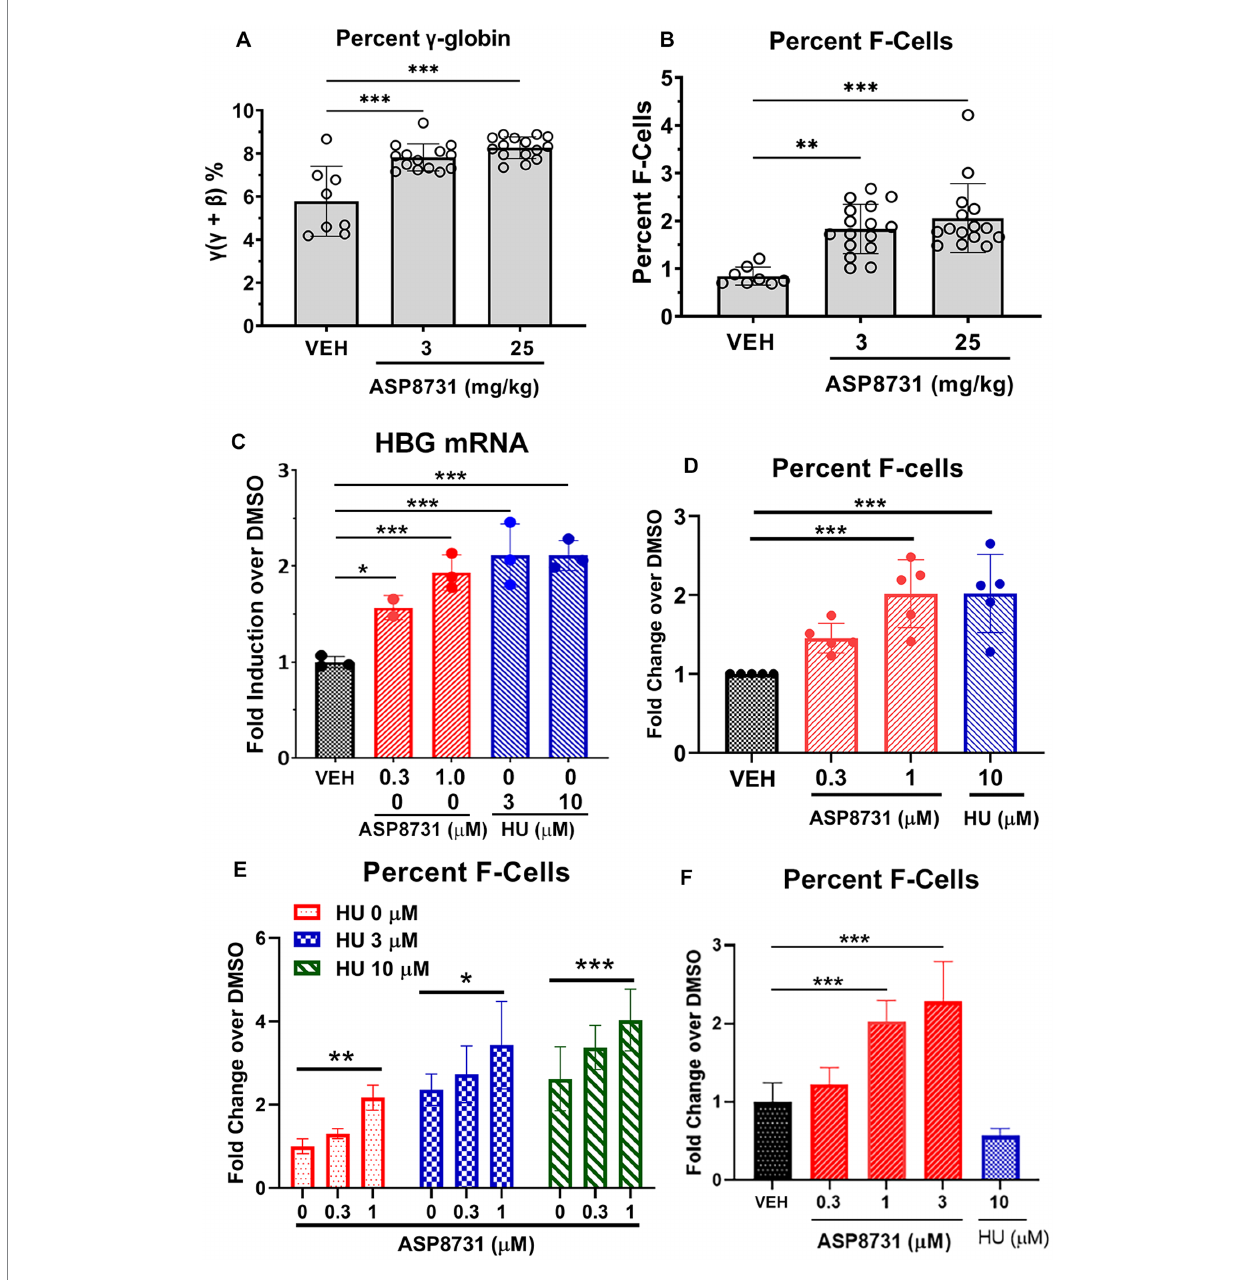
FIGURE 4 BACH1 inhibitor ASP8731 induces gamma globin and F-cells in HbSS mice and human erythroid differentiated CD34 cells. Townes HbSS mice ( n = 8–16 mice/treatment, equal males and females) were gavaged once daily for 14 consecutive days with vehicle (VEH, n = 8 mice) or ASP8731 at 3 mg/kg ( n = 16 mice) or 25 mg/kg ( n = 16 mice). Whole blood was collected on the last day of treatment and the red blood cells (RBC) were lysed in water and membrane debris was moved by centrifugation and filtration. (A) Gamma ( ɣ )-A and beta ( β )-S globins in the lysed RBC supernatants were measured by reverse phase HPLC and expressed as percent gamma-globin ( ɣ / ɣ + β ). (B) HbF containing F-cells in whole blood were measured by FACS and expressed as percent F-cells [(HbF+ and Ter119+)/total RBC (Ter119+)]. (C–F) Human BM derived CD34+ cells were expanded (days 1–7)